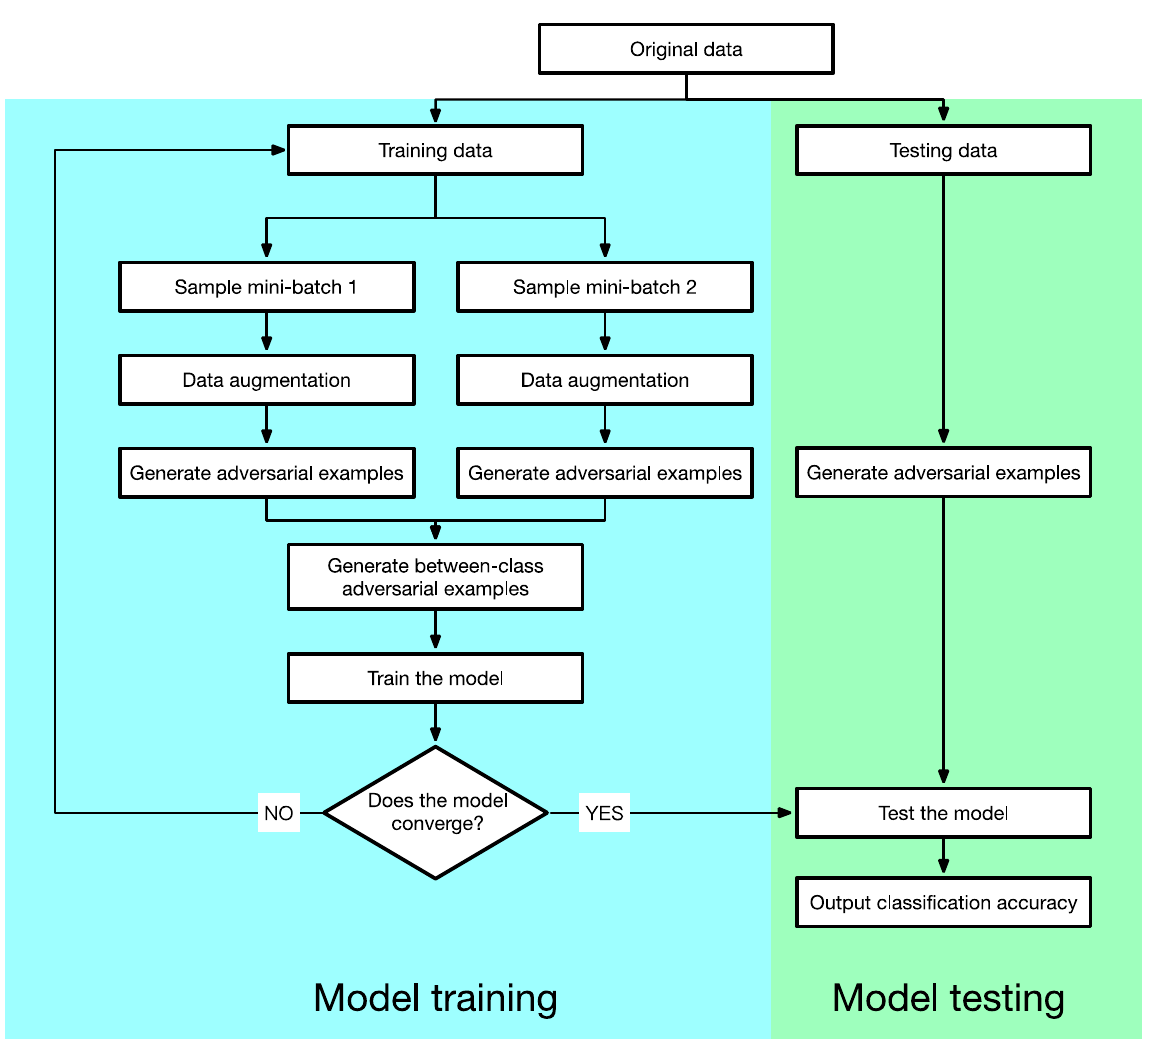
Figure 5. Overall framework of the proposed method.